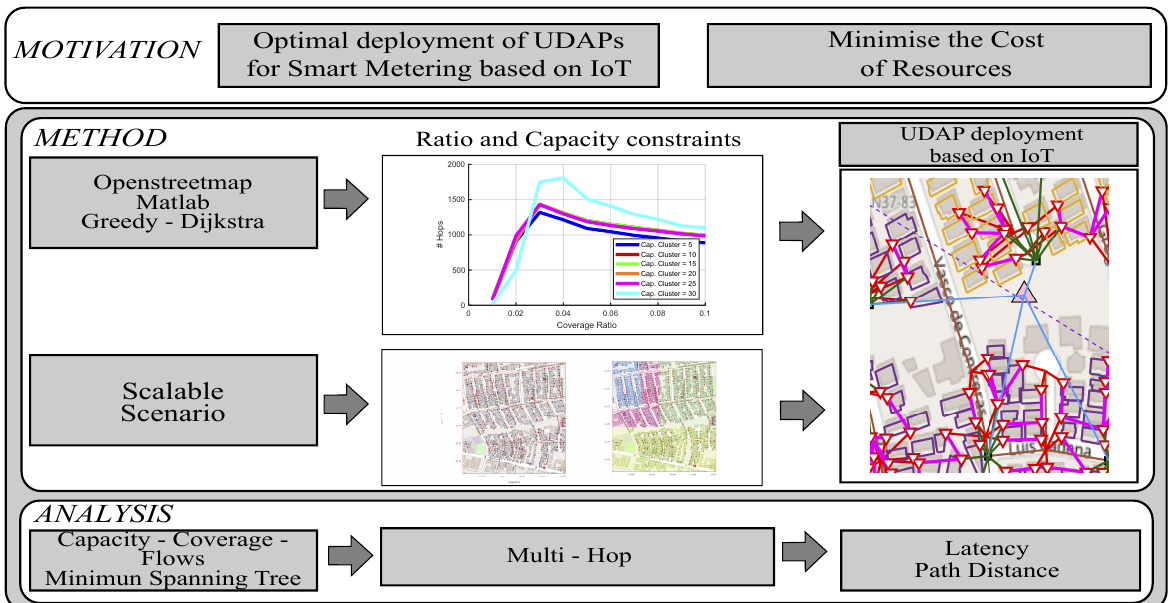
Figure 1. Proposed algorithm for optimal UDAP